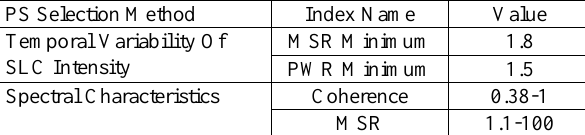
Table 2. PS selection methods used in image